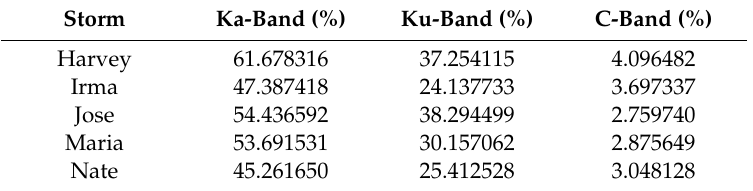
Table 5. Percentage of Rain Contamination (Serious and Side Lobe) using 11.0 km Footprint. Storm Ka-Band